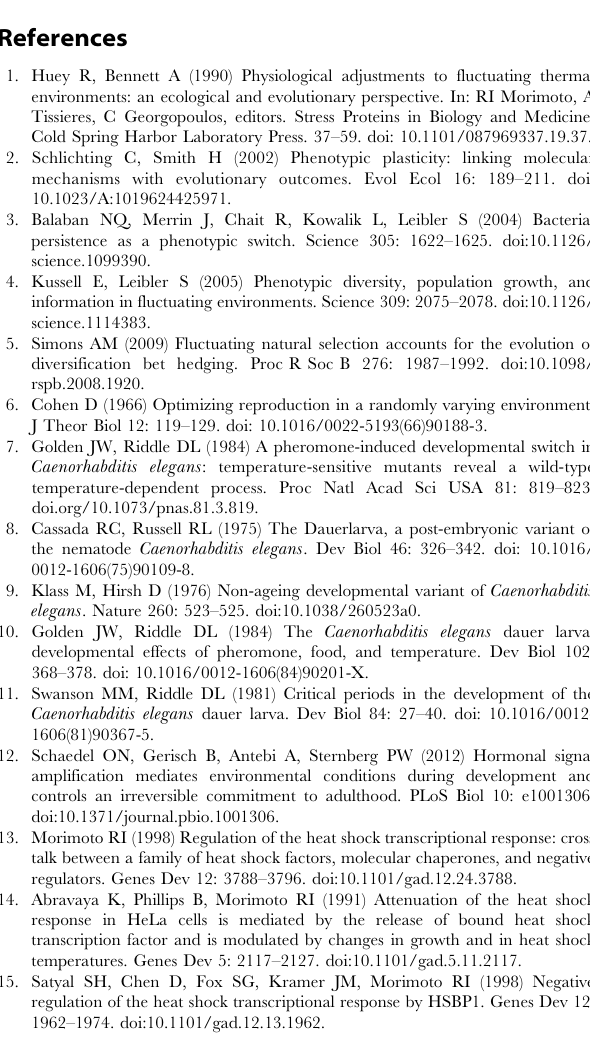
Table S5 Timeline for a 24-hour heat stress experi- ment. Table S6 Summary of the number of individual worms tested in all